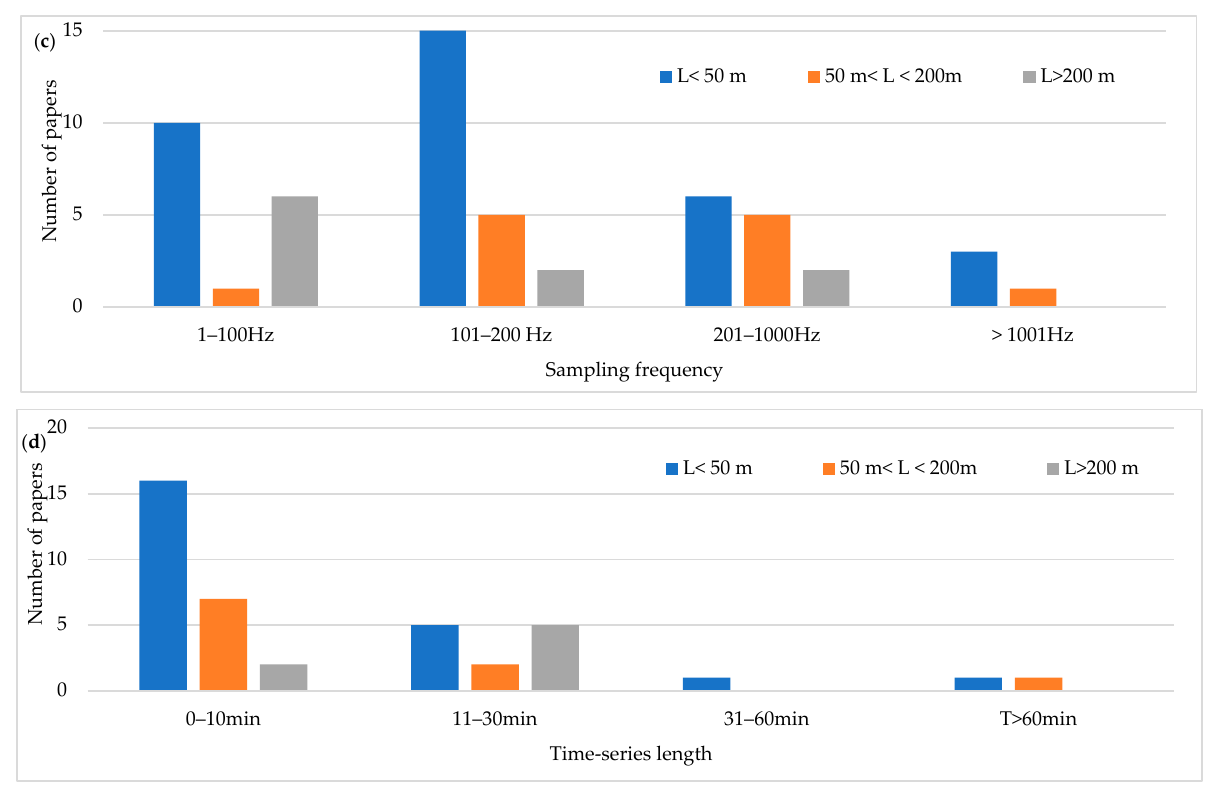
Figure 5. Distribution of the variables as a function of the main span length L: ( a ) Excitation source ( b ) sensor-to-sensor separation distance ( c ) Sampling frequency ( d ) Time-series length.